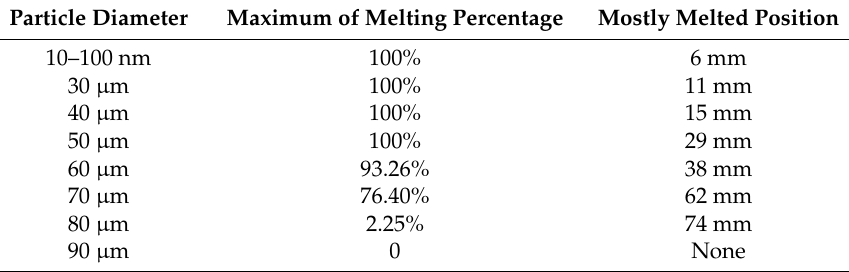
Table 1. Melting percentage and position for nanoparticles and agglomerates. Particle